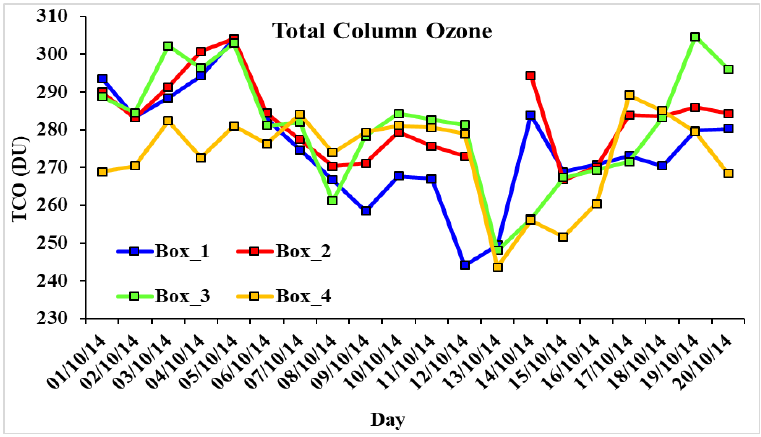
Figure 10. Total column ozone (TCO) over all four 2 o × 2 o boxes, showing a decrease in TCO on